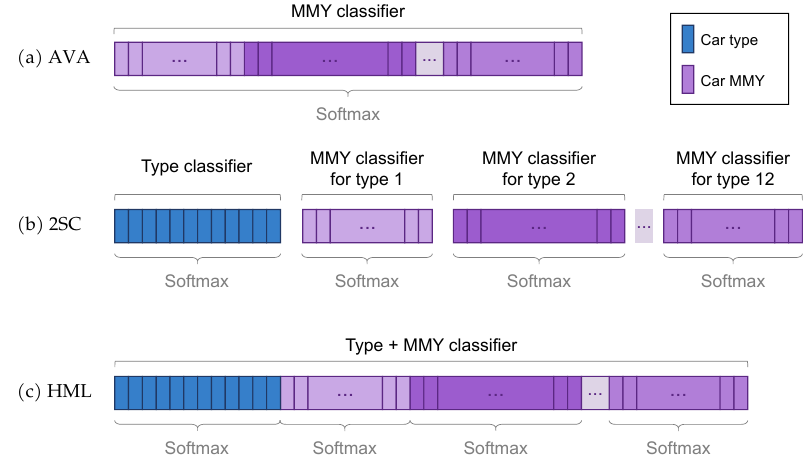
Figure 6. Visual representation of the classifier output for the three presented approaches. ( a ) all- vs.-all uses a unique classifier for all the finest-level make–model–year classes (MMY); ( b ) two-step cascade defines a first car-type classifier whose output points to one of 12 type-specific MMY classifiers; ( c ) hierarchical multilabel uses a single classifier to simultaneously predict type and MMY, but the backpropagation is guided by independent softmax functions for the type outputs, and for each group of type-specific